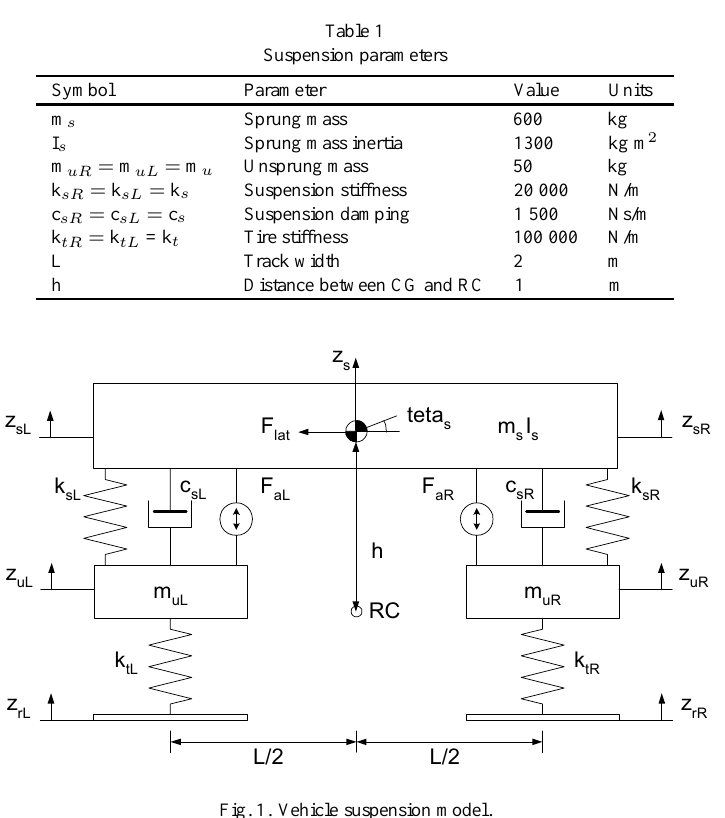
Fig. 1. Vehicle suspension